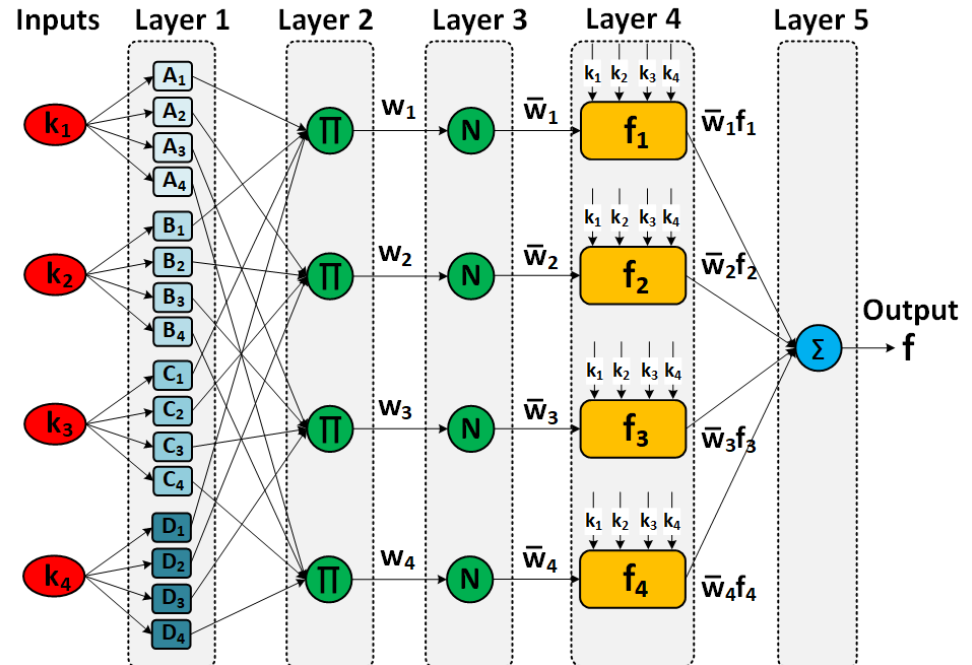
Figure 1. ANFIS architecture.